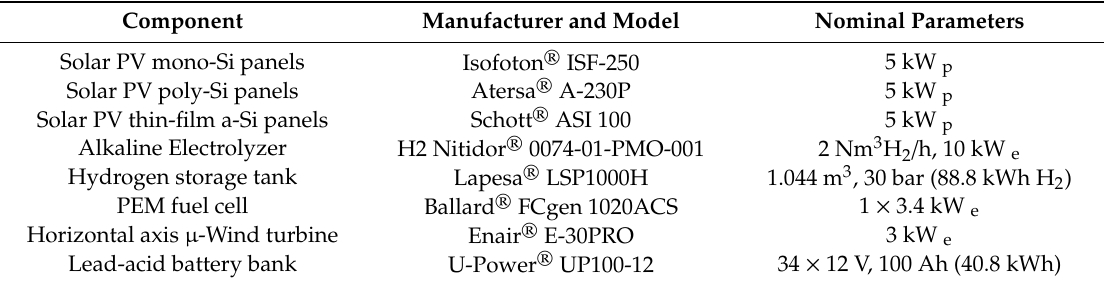
Table 1. Technical characteristics of components from microgrid shown in Figure